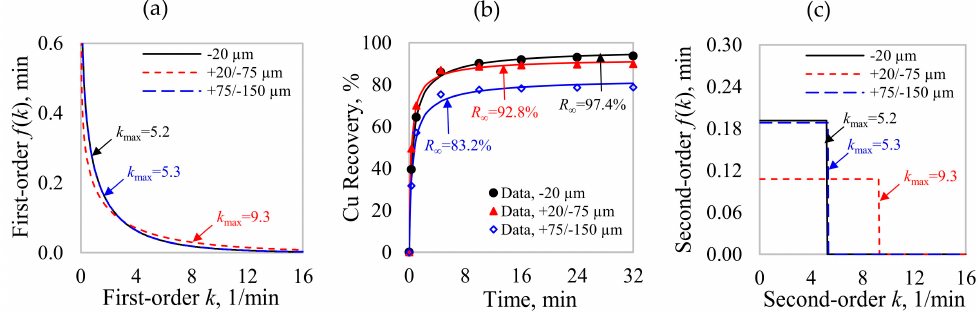
Figure 3. ( a ) Representation as first-order f ( k )s from second-order models with Rectangular f ( k )s, ( b ) Time-recovery curves, Table 4, ( c ) Second-order f ( k )s, Rectangular distributions.